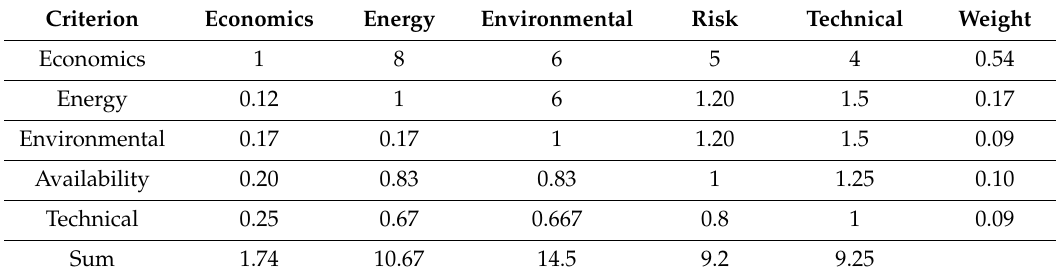
Table A1. Pairwise comparison of criteria.